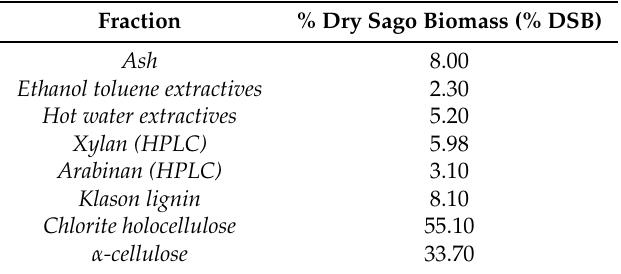
Table 2. Chemical composition of sago biomass.